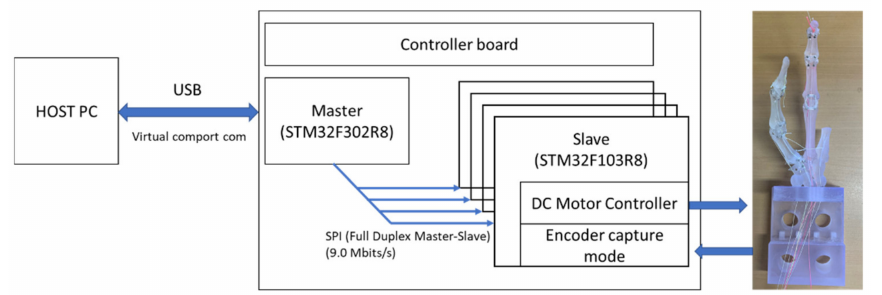
Figure 12. Schematic of the 20-channel control board with serial communication between HOST PC and the board and between the main board and slave board at the controller